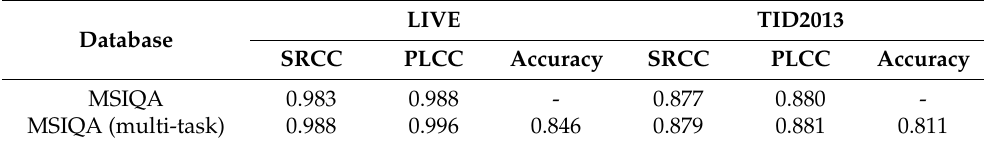
Table 6. SRCC and PLCC and classification accuracy on LIVE and TID2013 databases.